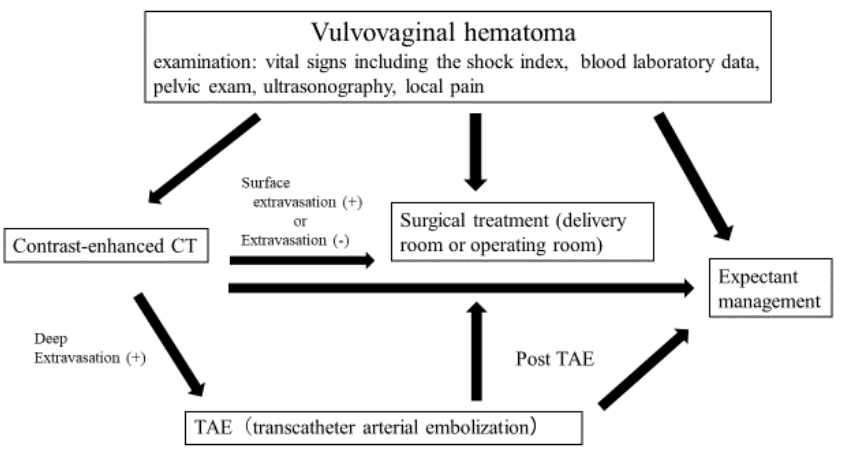
Figure 1. Algorithm for vulvovaginal hematoma treatment at our hospital.